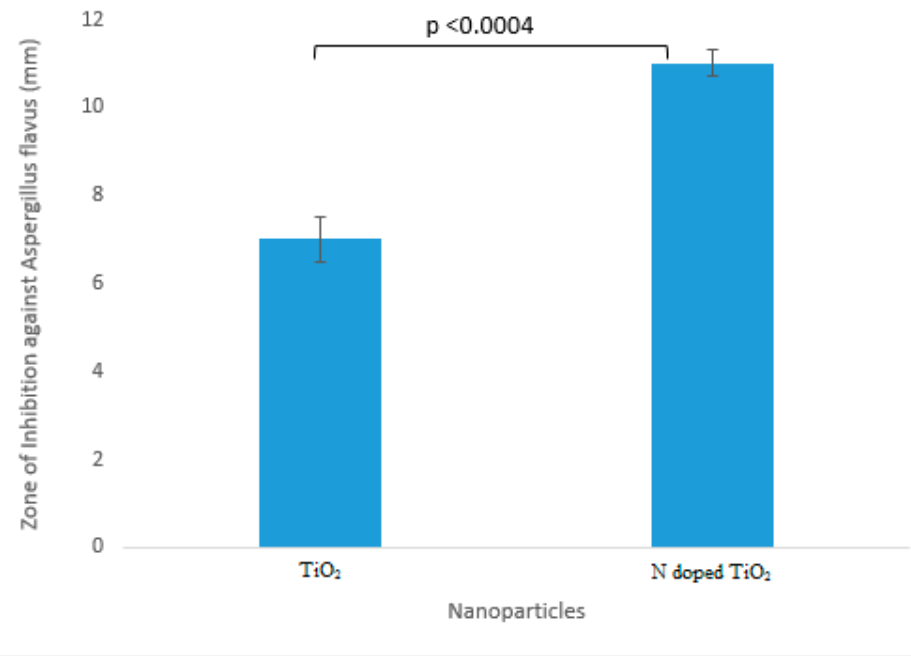
Figure 8. Antifungal activity exhibited by TiO 2 nanoparticles and N-doped TiO 2 nanoparticles against Aspergillus flavus. Error bars are shown as standard deviation on each bar. Bars are significantly different at confidence interval level of 95%.